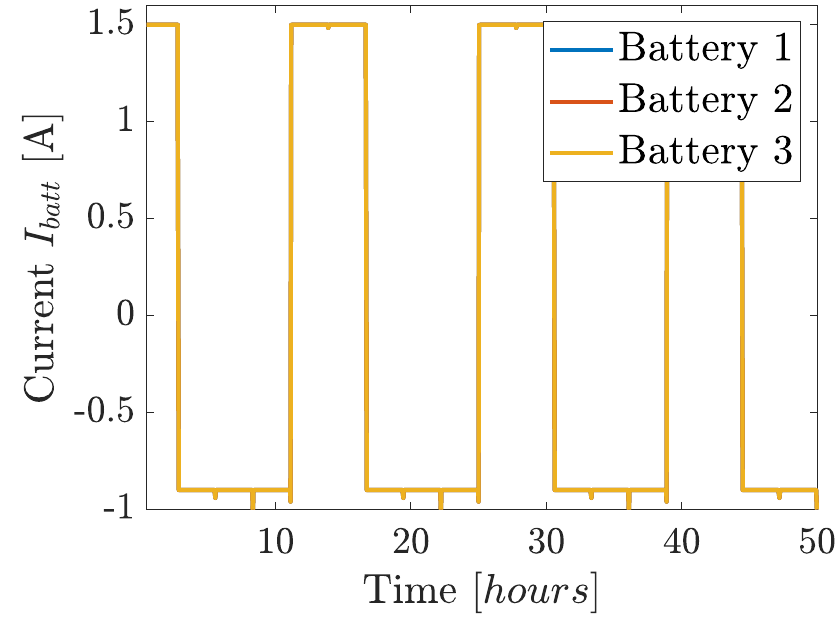
Figure 24. Current values considering the SoH